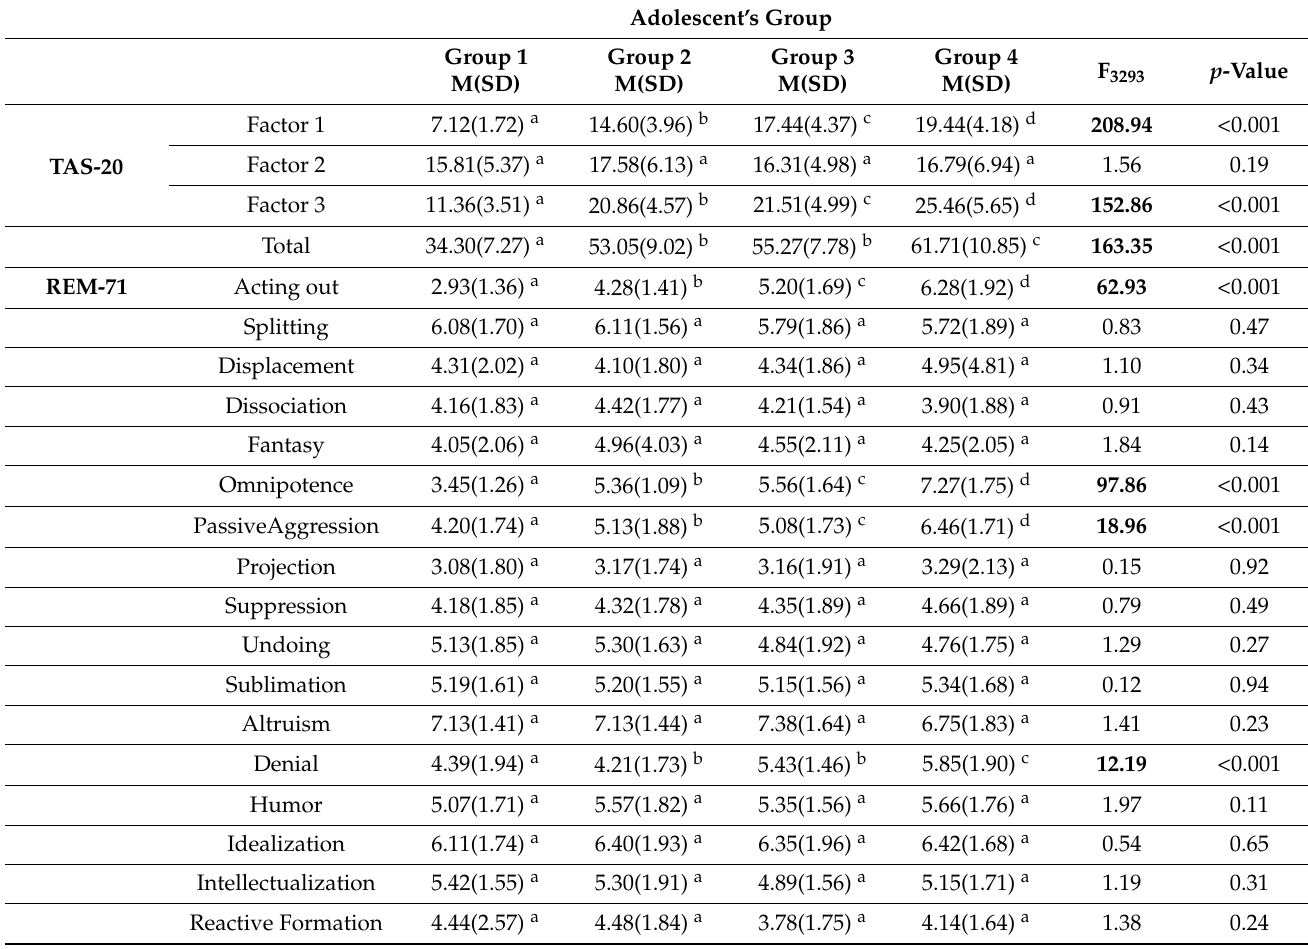
Table 3. Univariate results of the differences between the three groups in youth’s family functioning, impulsivity, depression and anxiety problems between youth’s sex and